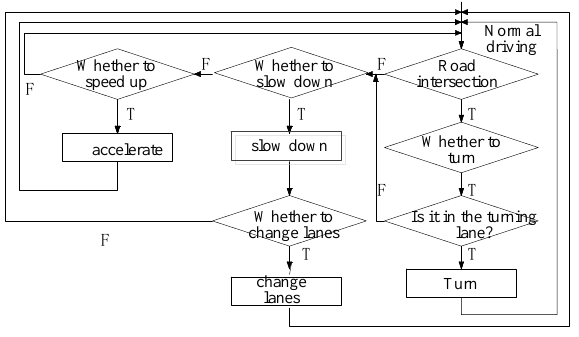
Figure 4. Simulation driving implementation flow